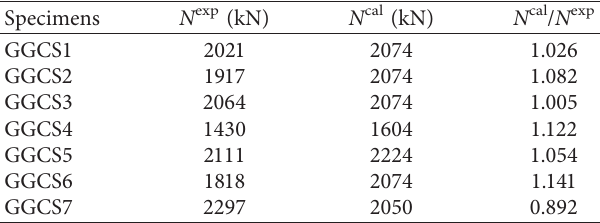
Table 5: Experiment results and calculated